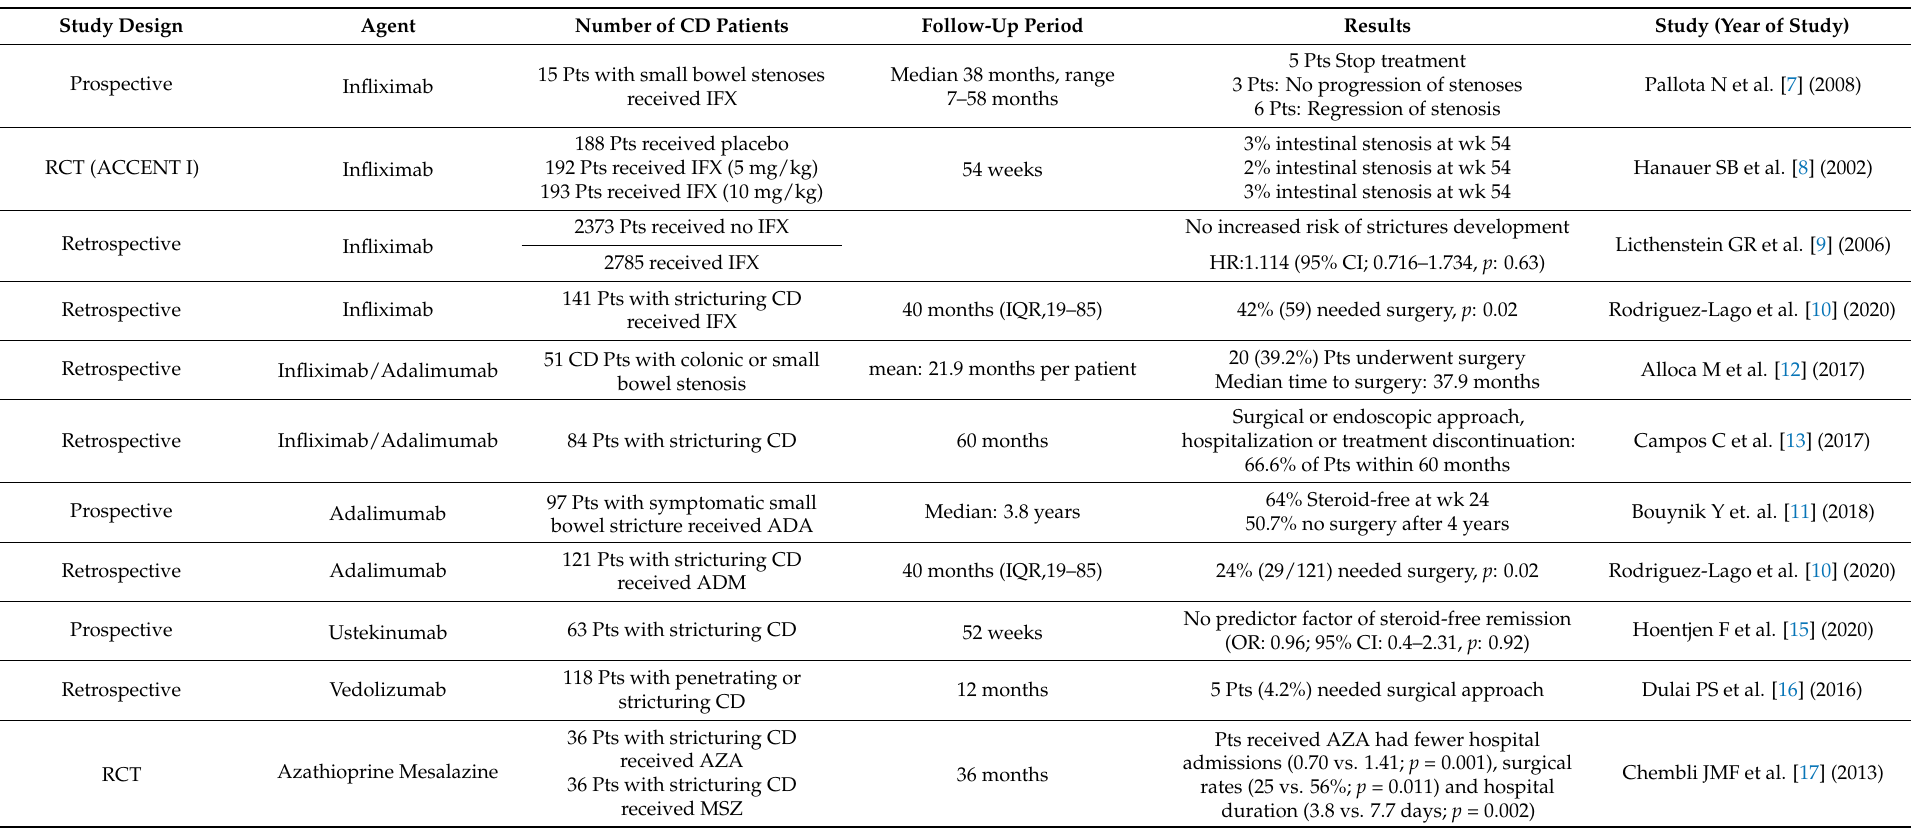
Table 1. Studies about medical therapy of stricturing Crohn’s